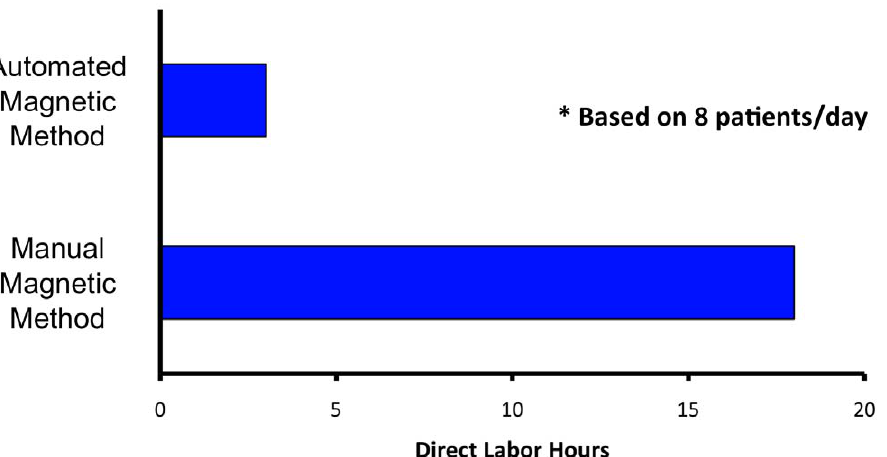
Figure 4. Comparison of labor hours needed to perform manual versus automated CD8 cell separation in our laboratory. Based on our workflow, one research associate works 4.5 hours to process blood samples from one diabetic patient and one control; or a total of 18 hrs for 8 patients. In our current automated setup one associate can initiate the processing of 8 samples in parallel and finish in 3 hrs while being able to perform other activities once setup is completed. Such dramatic savings in amount of direct labor will translate in large cost savings and increased throughput.